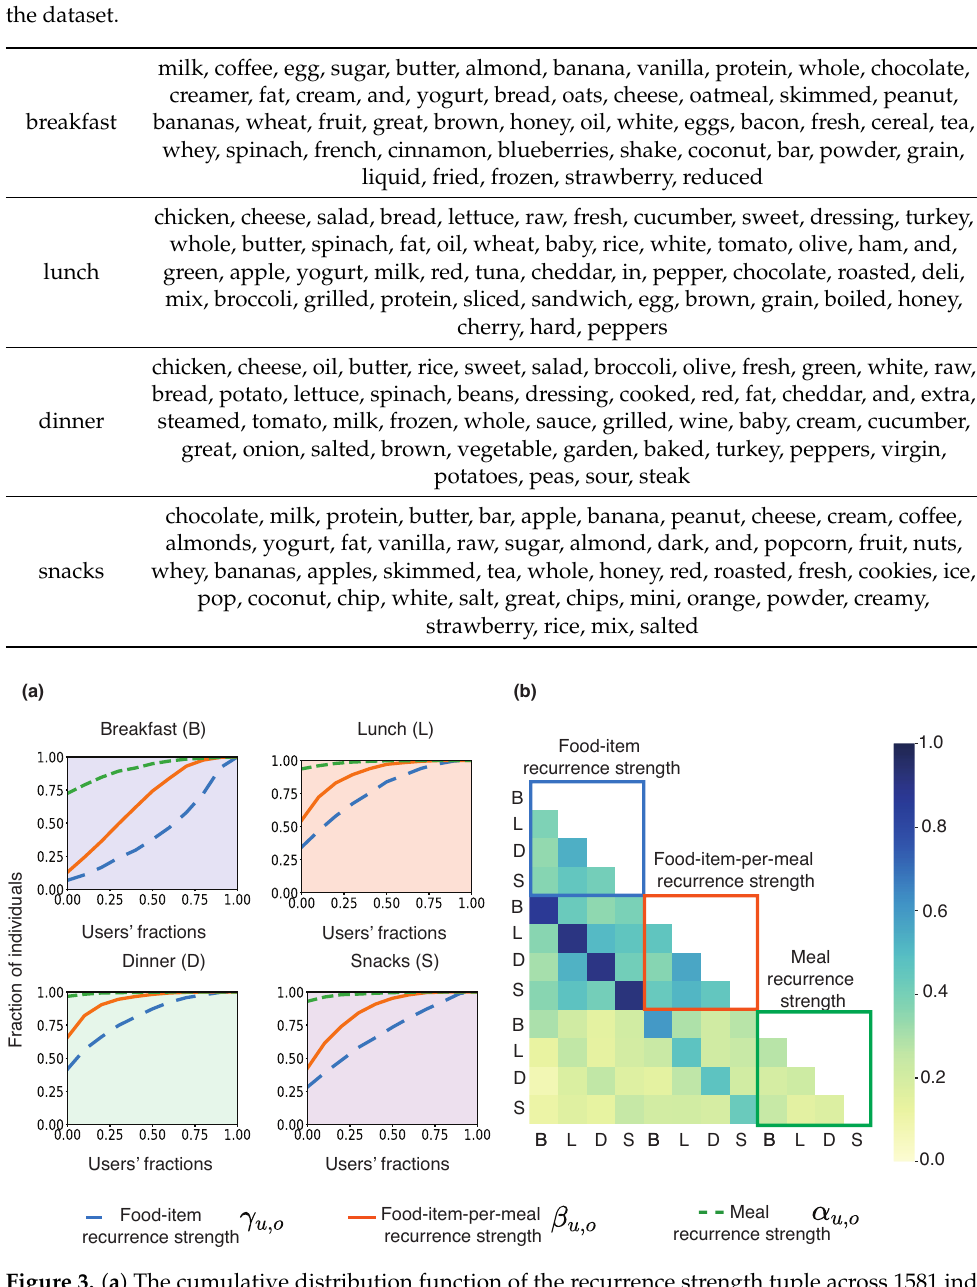
Figure 3. ( a ) The cumulative distribution function of the recurrence strength tuple across 1581 indi- viduals. ( b ) Heatmap of correlations between the recurrence strength tuple across all meal